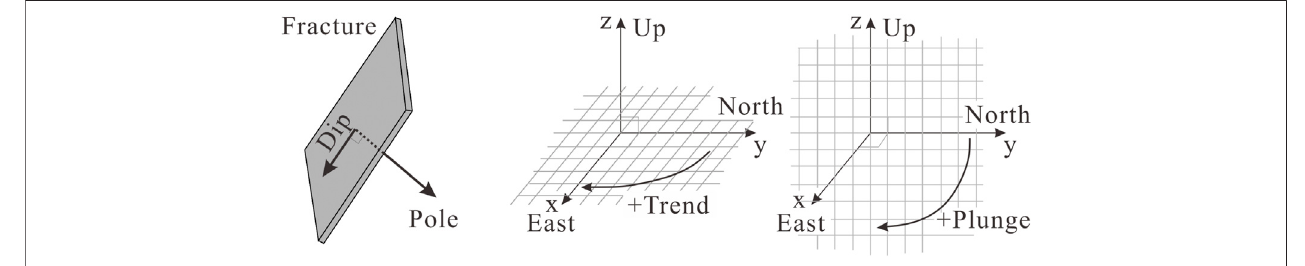
FIGURE 2 | (A) Vertical fracture dip and pole, both pointing downward; (B) the pole trend in the x-y plane; and (C) a pole plunge in the y-z (or x-z)